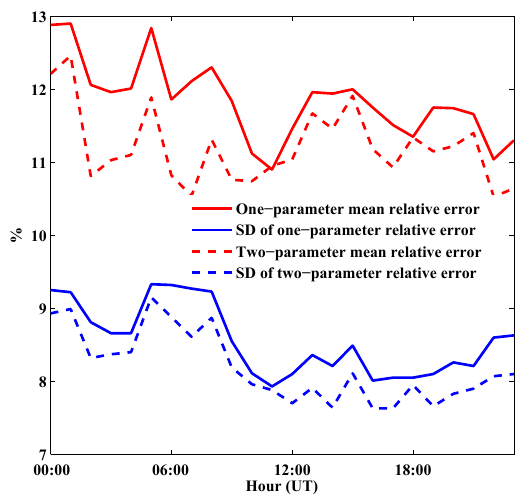
Figure 10. The comparisons between the average relative error and standard deviation of the relative error using regularization method II and the average relative error and standard deviation of the rel- ative error using the single-parameter regularization method under background II